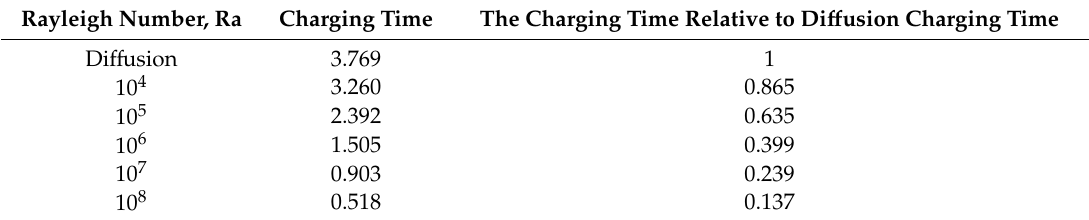
Table 2. Charging time obtained for various Ra values and R in = 0.1. Rayleigh Number,